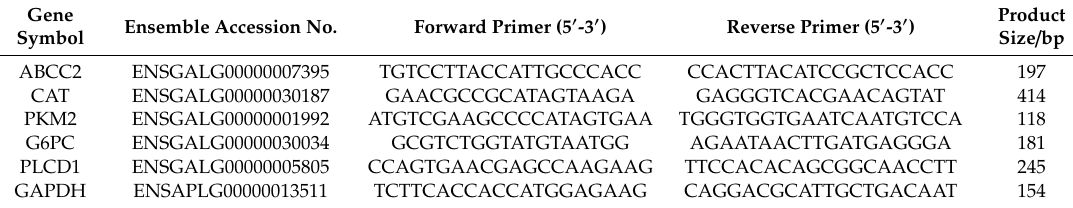
Table 2. Nucleotide primer sequences of the PCR primers.